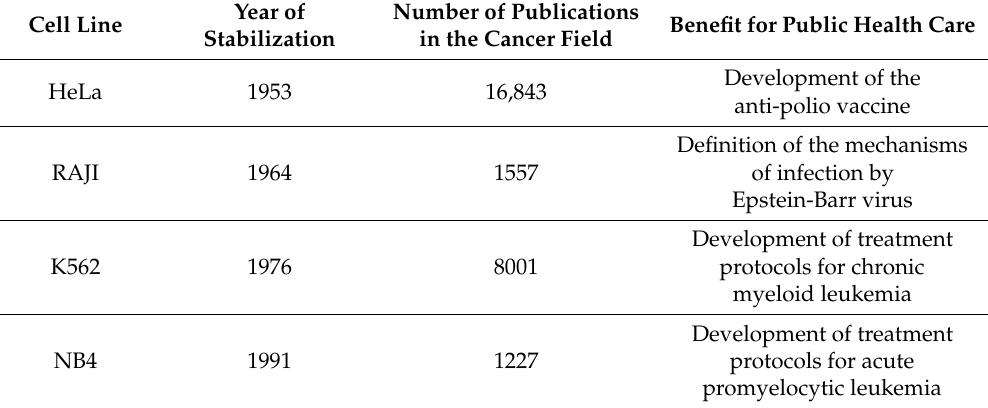
Table 1. Contribution of some historical cell lines to milestones in cancer research and health care. The number of publications was derived through access to PubMed (https: // www.ncbi.nlm.nih.gov / pubmed / ) on 28 May 2019 and applying the following search criteria: (i) (hela [Text Word]) AND